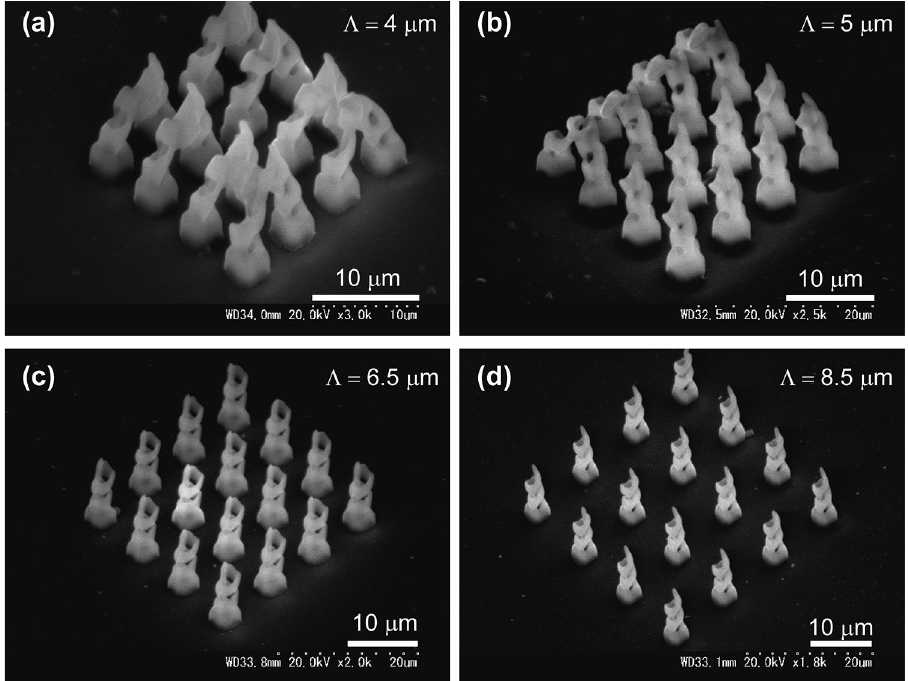
Figure 6. SEM images of the fabricated helix structures with various neighboring distance of 4 μm in ( a ), 5 μm in ( b ), 6.5 μm in ( c ), and 8.5 μm in ( d ).